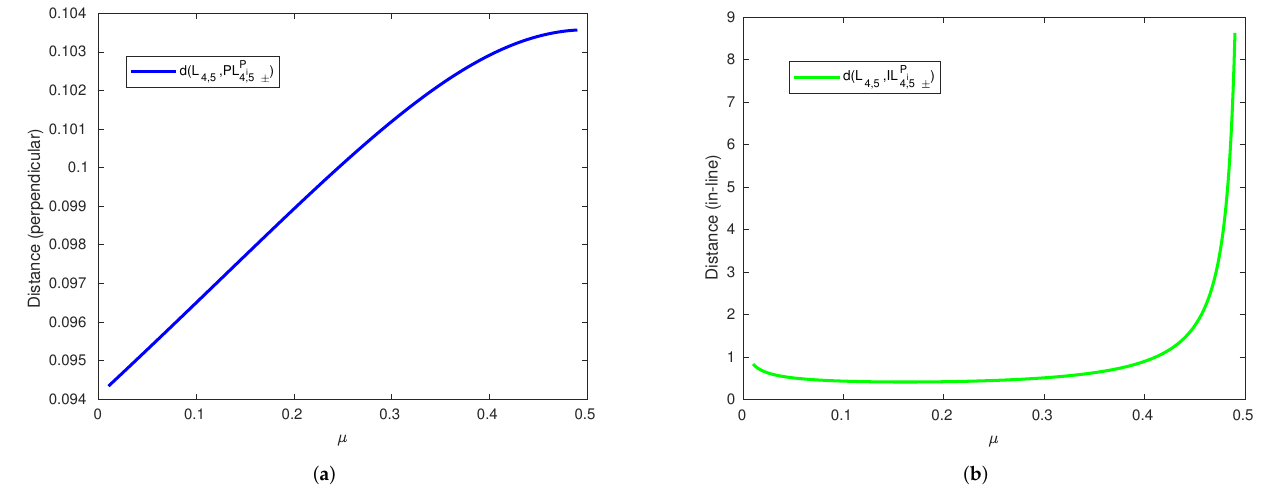
Figure 5. Distance versus µ in the presence of the planetesimal belt effect for noncollinear equilibrium points. ( a ) Perpendicular equilibrium points. ( b ) Inline equilibrium points.